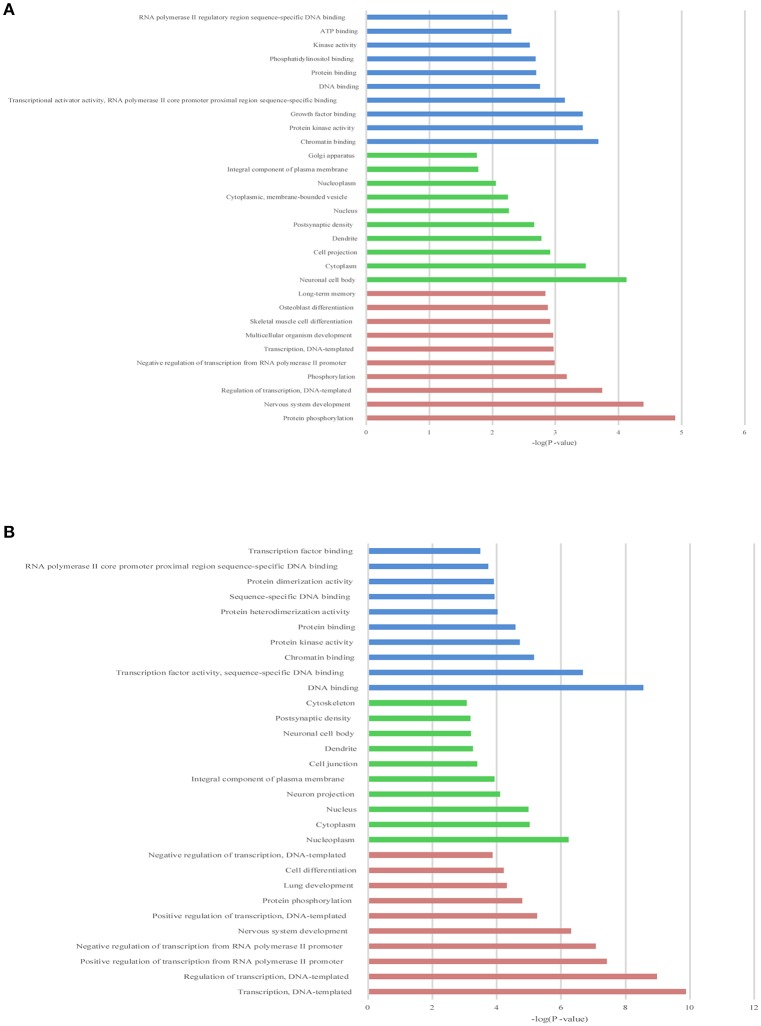
The top 10 enrichment scores in gene ontology (GO) enrichment analysis on target genes of differentially expressed lncRNAs. (A) Analysis of the up-regulated lncRNAs; (B) Analysis of the down-regulated lncRNAs. Red bars represent biological process terms; Green bars represent cell component terms; Blue bars represent molecular function terms.